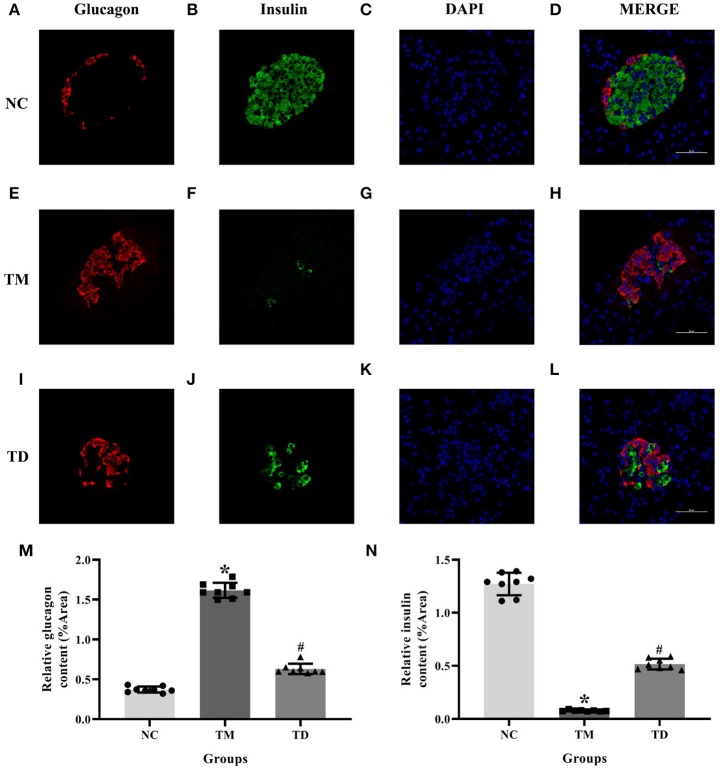
Immunolocalization of insulin and glucagon in rat islet tissues. (A–D) NC group; (E–H) TM group; and (I–L) TD group. (M,N) Relative GLUT2 and GPER content. Immunofluorescence double staining confocal of rat islet β cells for glucagon (red), insulin (green). Nuclei were stained with DAPI (blue) and merged images. Scale bars: 50 μm. DAPI, 4′, 6-diamidino-2-phenylindole; NC, the normal control group; TM, the type 2 diabetes mellitus group; TD, the type 2 diabetes mellitus drug-treatment group. n = 8 rats in each group. Results of one-way ANOVA demonstrated *P < 0.05 compared to the NC group. #P < 0.05 compared to the TM group. Data were presented as the mean ± standard deviation.